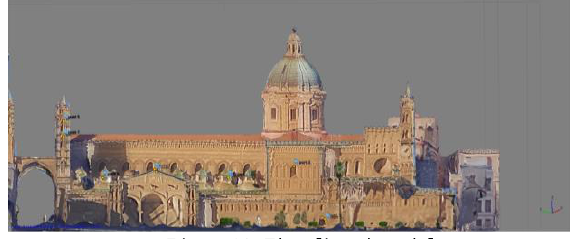
Figure 13. The aligned